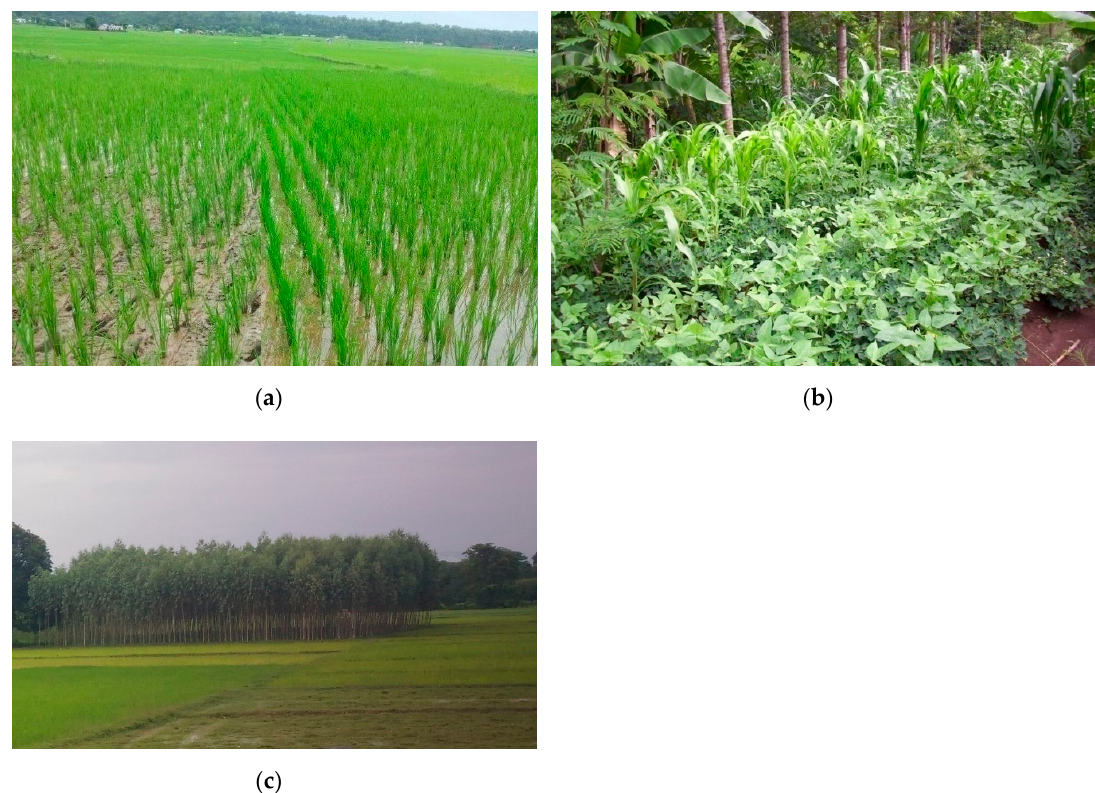
Figure 2. ( a ). Conventional agriculture (Paddy), ( b ) Alley cropping, ( c ) Agroforest/woodlot.